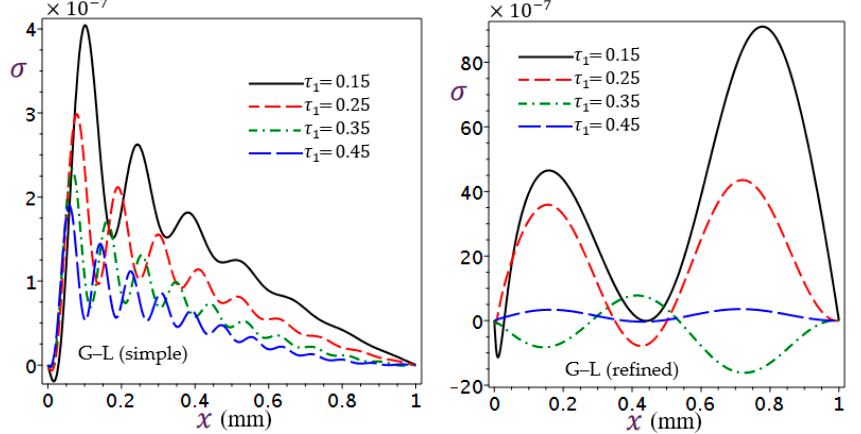
Figure 13. Effect of first relaxation time τ 1 of G–L theory on normal stress σ .